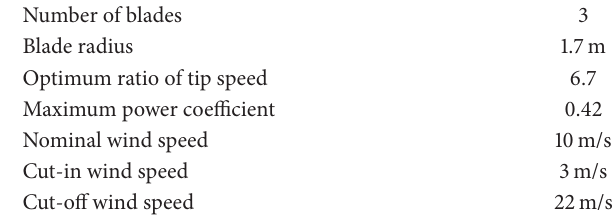
Table 1: Wind turbine parameter.